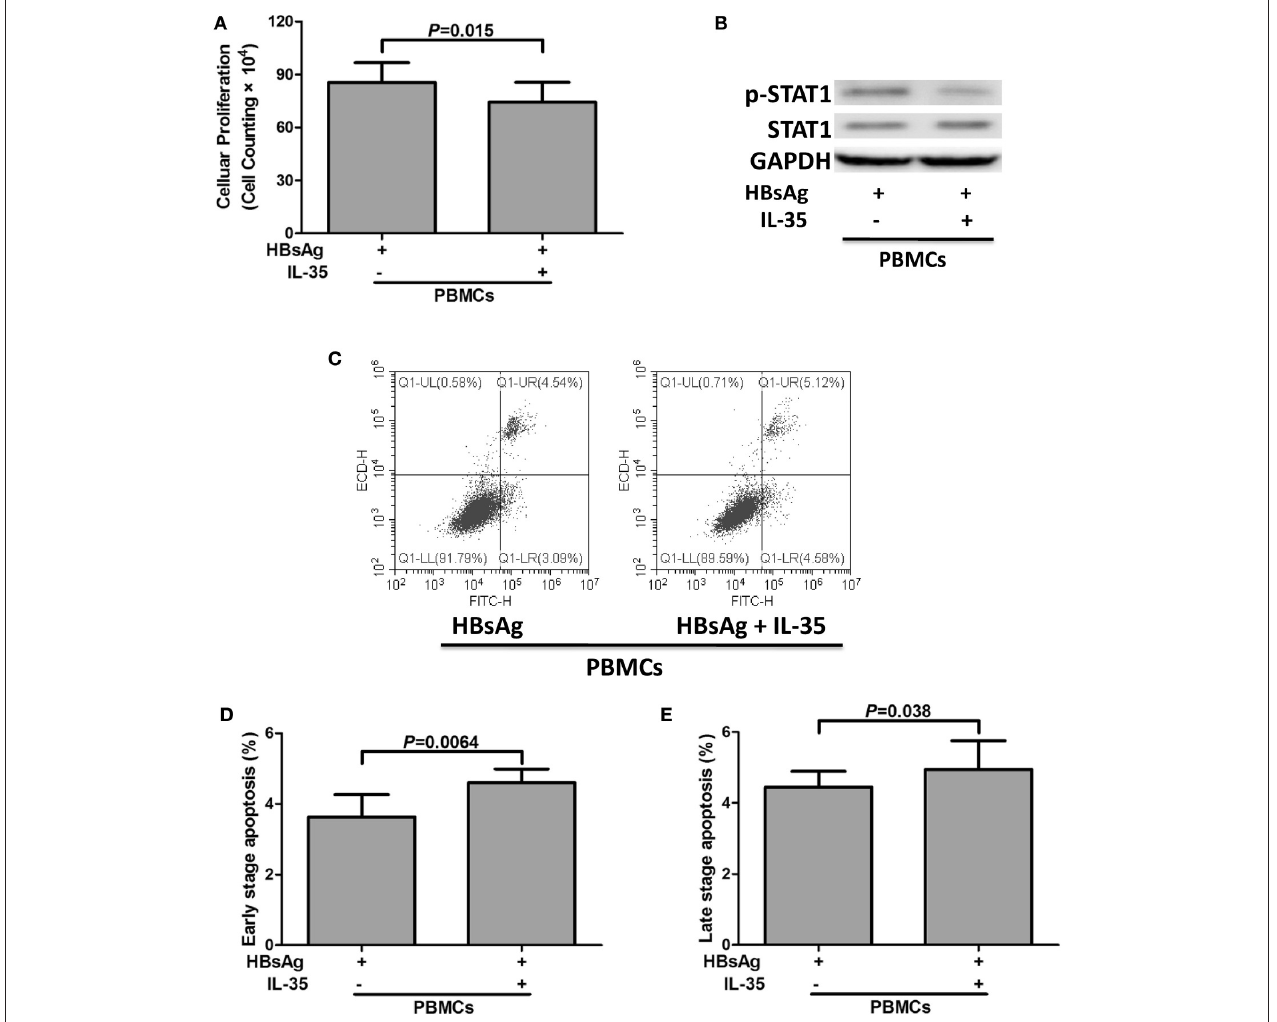
FIGURE 2 | The regulatory role of interleukin (IL)-35 in peripheral blood mononuclear cells (PBMCs). PBMCs isolated from patients with chronic hepatitis B (CHB, n = 10) were stimulated recombinant hepatitis B surface antigen (HBsAg) in the presence or absence of recombinant IL-35 for 24h. (A) Cellular proliferation was measured by cell counting kit-8. The data were presented as mean ± SD, and significances were calculated using paired t- test. (B) Phosphorylated STAT1 (p-STAT1) and total STAT1 were tested by Western blot, and GADPH was shown as control. (C) Representative flow cytometry analysis for apoptotic cells were shown in both PBMCs. Annexin V + PI − cells (lower right) represented early stage apoptotic cells, while Annexin V + PI + cells (upper right) represented late stage apoptotic cells. The percentages of early stage apoptotic cells (D) and late stage apoptotic cells (E) were shown. The data were presented as mean ± SD, and significances were calculated using paired t-